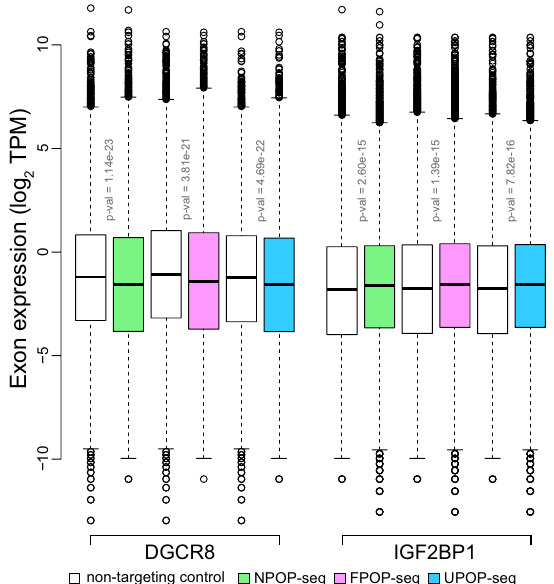
Figure 4. Comparison of POP-seq data with CRISPR knock out RNA-sequencing data of RBPs. Box plot showing the cumulative exon expression levels proximal (< 1000 bp) to POP-seq peaks overlapped (50% end to end peak overlap) with the eCLIP profile of DGCR8 and IGF2BP1 in K562 cells (ENCODE project). The exon expression levels of respective RBP CRISPR Cas9 knock out was compared with respective non-targeting Crispr control and statistically tested using Wilcoxon